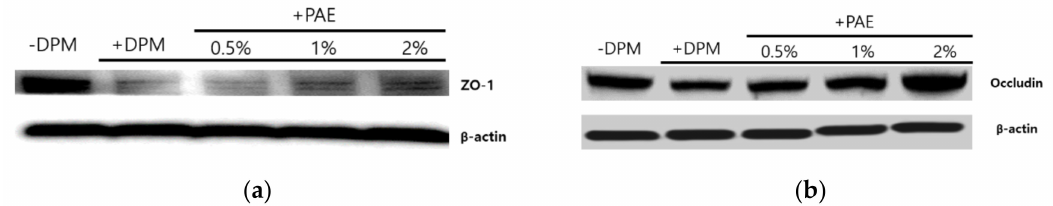
Figure 6. DPM dysregulated cell adhesion proteins, and PAE played a role in maintaining homeostasis. DPM displayed downregulation of desmosomal or tight-junction components. Zonula Occludens-1 (ZO-1) ( a ) and Occludin ( b ) expressions were repressed at the protein level, and the perturbation of homeostasis was reversed by PAE, indicating a protective